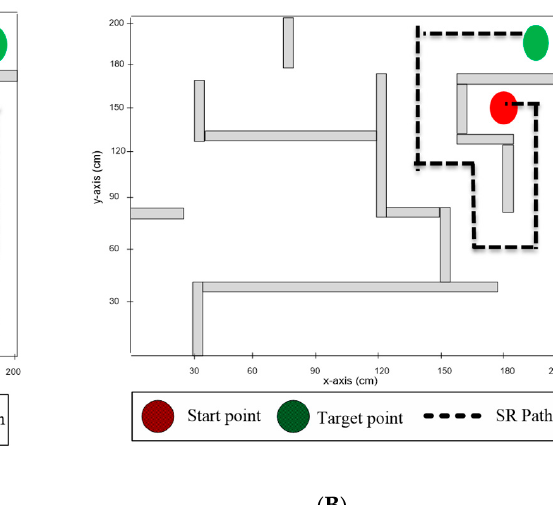
Figure 9. The total traveled distance of the solver robot for 4 algorithms in testbed # 1.